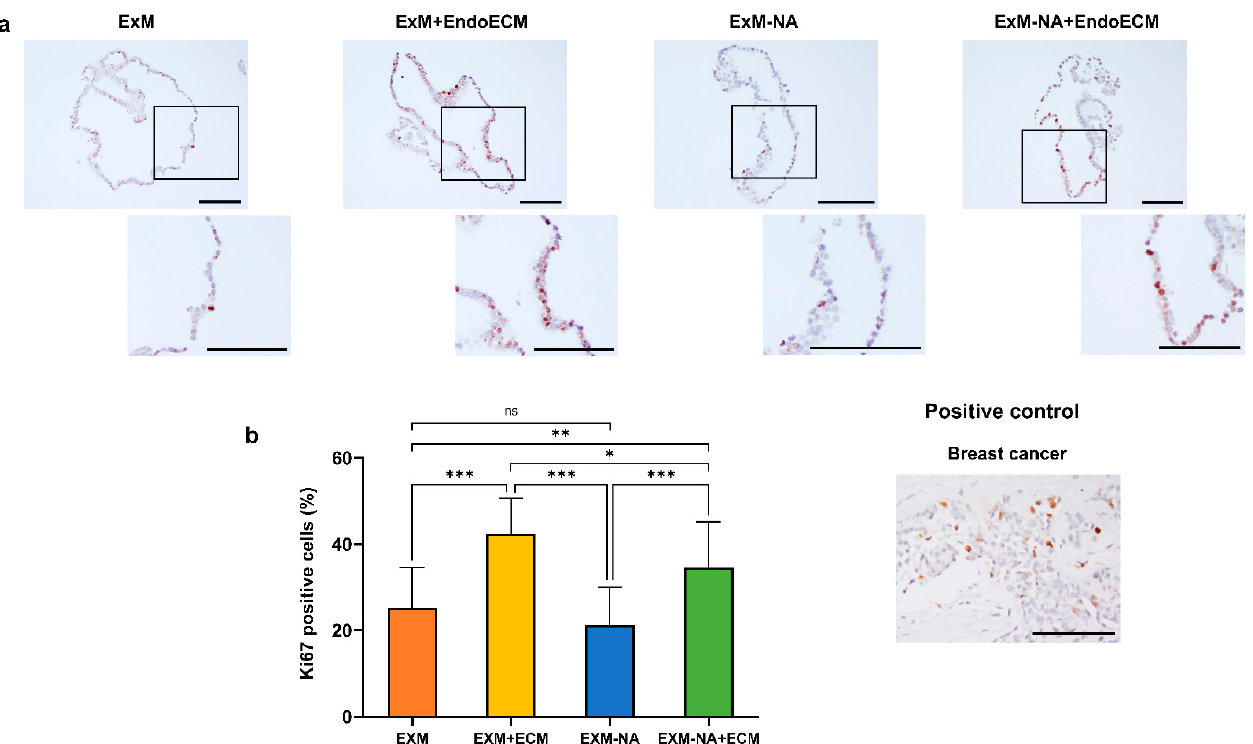
Figure 6. Human endometrial organoids proliferation assay. ( a ) Immunohistochemistry for Ki67 expression in breast cancer and organoids cultured in the four different experimental conditions ExM, ExM+EndoECM, ExM-NA, ExM-NA+EndoECM. ( b ) Percentage of Ki67 positive cells in organoids. * p < 0.05, ** p < 0.01, *** p < 0.0001. Scale bars are 100 μ m.